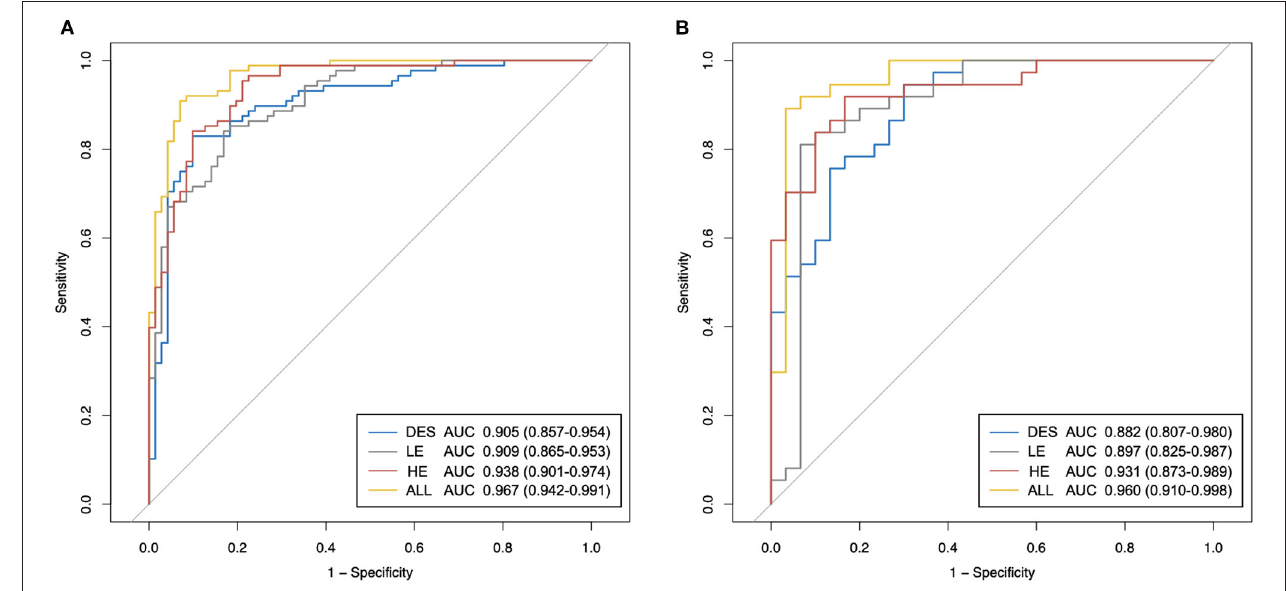
FIGURE 6 | The receiver operating characteristic (ROC) curves of the proposed best classification models of different types of contrast-enhanced mammography (CEM) images. (A) ROC curves in the training set. (B) ROC curves in the testing set. HE, high-energy; LE, low-energy; DES, dual-energy subtraction; “ALL” stands for a combination of HE, LE, and DES images.